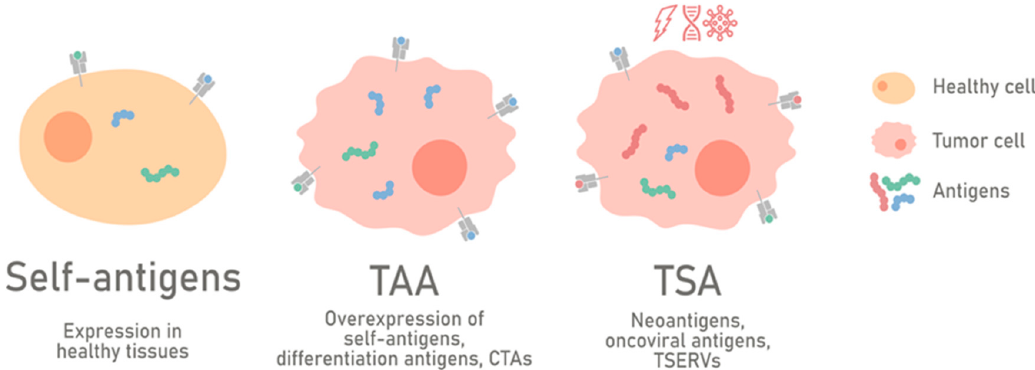
Figure 1. Classification of tumor antigens. Tumor antigens can generally be categorized into tumor- associated antigens (TAAs) and tumor-specific antigens (TSAs) based on the expression pattern of the parental gene. TAAs are self-proteins expressed in cancer cells; upon malignant transformation, the following consequences can be observed: the overexpression of normal proteins (gene overexpressed), the expression of proteins with tissue-specific gene patterns (differentiation antigens), or the expression of proteins derived from gene expression restricted to the testes (cancer germline/cancer testis antigens). TSAs are proteins expressed by tumor cells and can arise from mutations (neoantigens), from viruses involved in the oncogenic transformation (oncoviral antigens), or from the expression of tumor-specific endogenous retroviruses ( TSERVs ).